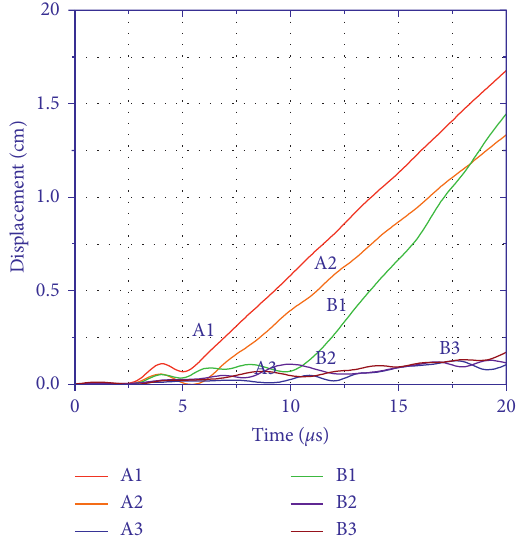
Figure 23: Joint displacement curves of shaped charge hydraulic blasting.